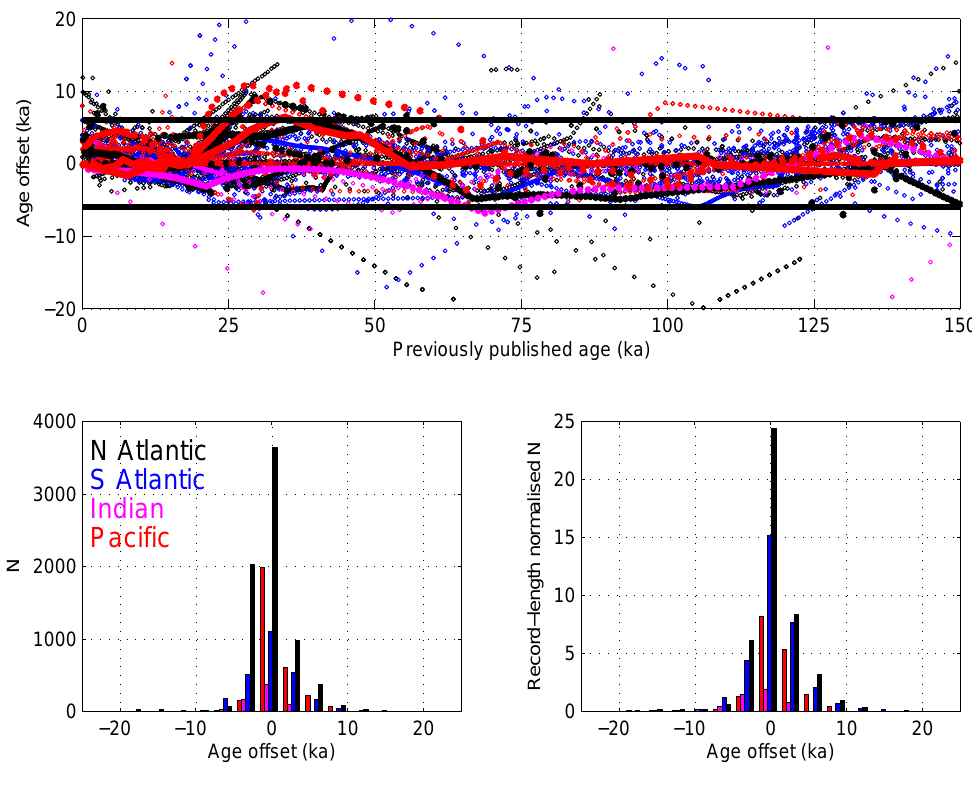
Fig. 4. (a) Offsets between age estimates used for this study and previously published (Table 1) age estimates as a function of age. Colours indicate ocean basin; bold filled circles indicate that 14 C data was used in the previously published age model (note that 14 C can only be used to improve age estimates for the last ∼ 50ka). The bold black line indicates offsets of ± 6ka. (b) Distribution of age estimate offsets. (c) Distribution of age estimate offsets, normalised by the number of observations within each record (i.e. an observation from a record of length n adds 1 /n , as opposed to 1, to the appropriate